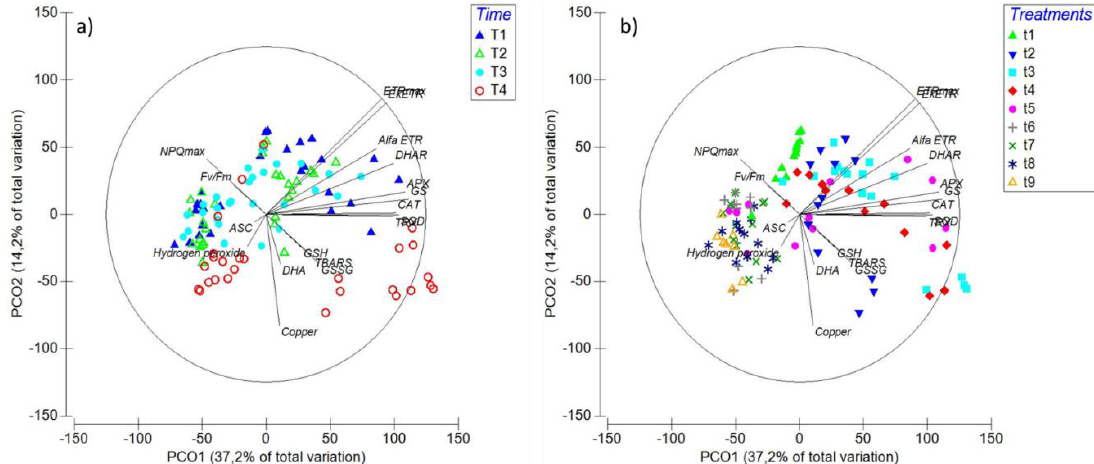
Figure 8. Principal Components Ordination (PCO) analysis diagrams considering the data covered in this article and in the parallel/complementary Celis-Plá et al. [1]. PCOs are related with time ( a ): T1: 6 h, T2: 24 h, T3: 48 h, and T4: 6 d; and treatments ( b ): t1: control only with seawater, t2: solely copper